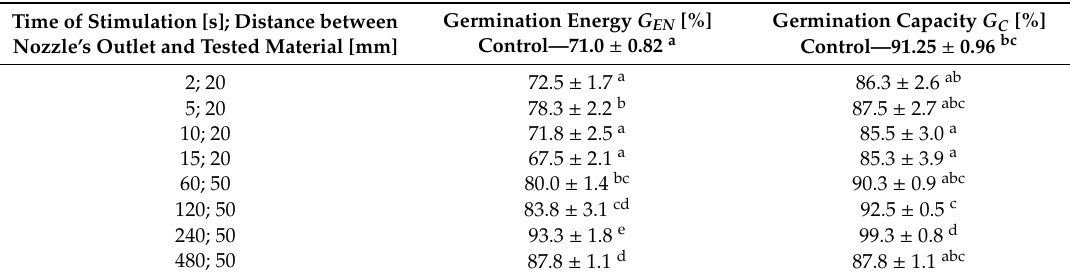
Table 2. The results on germination energy and germination capacity parameters of Wolska onion seeds after pre-sowing treatment with cold plasma at di ff erent exposure times and distance between electrode and tested